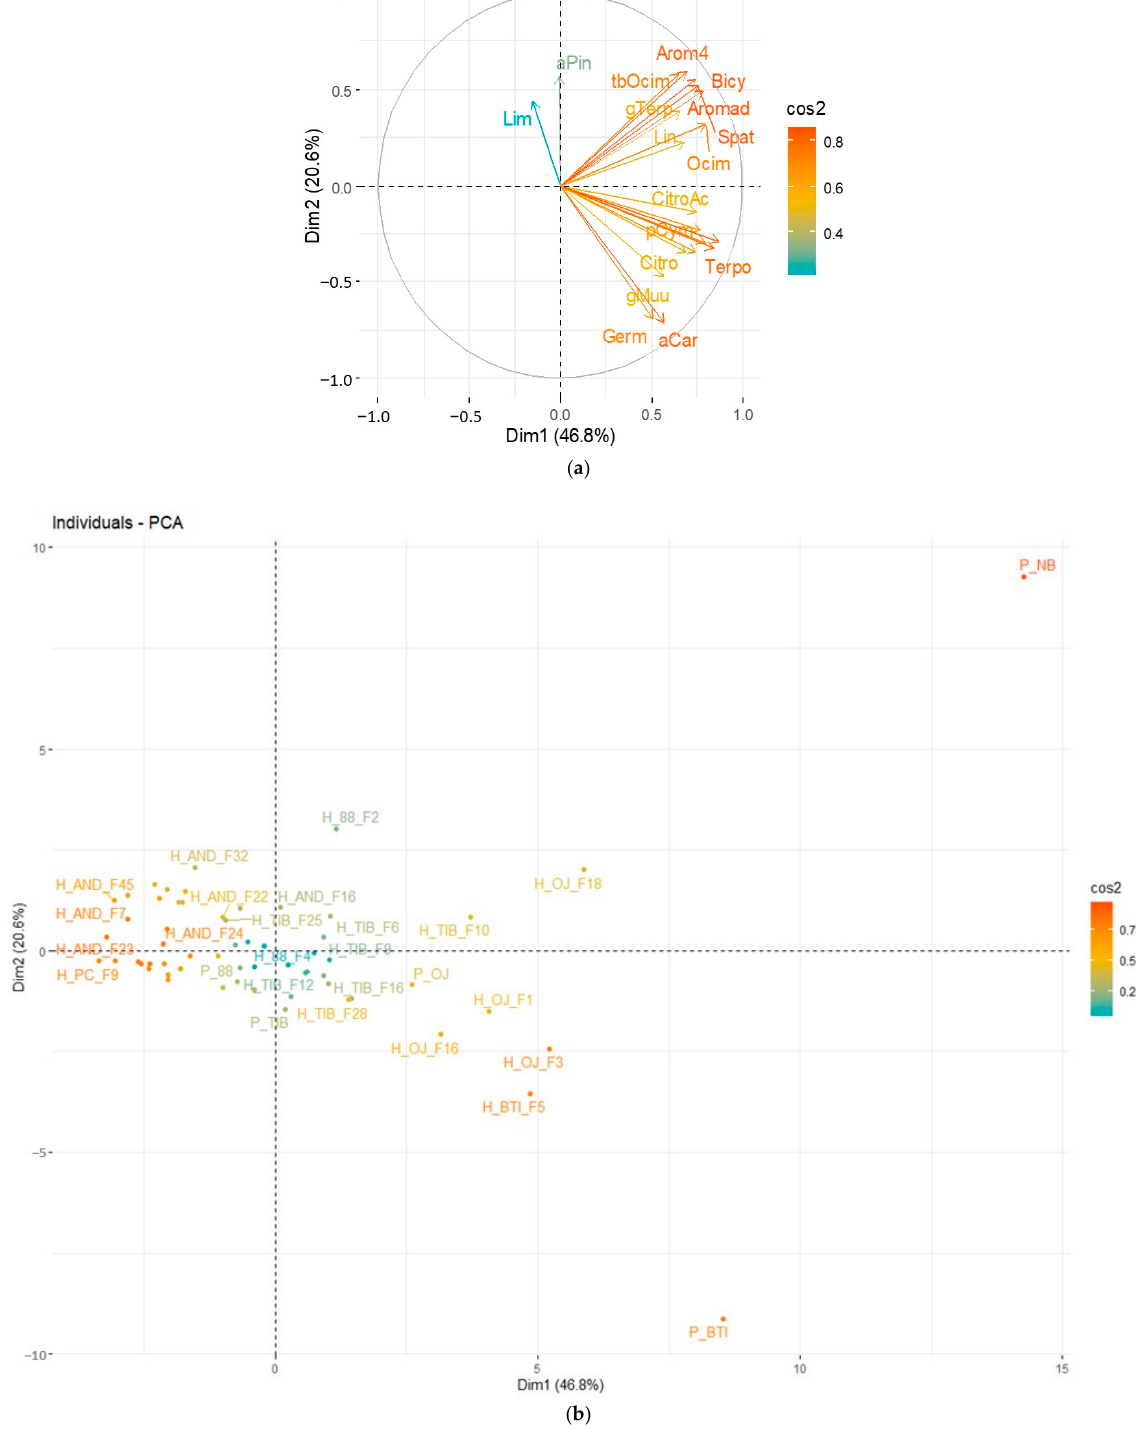
Figure 5. PCA plot released on the eight cultivars and hybrids for the 20 molecules retained in the fingerprint of Noir de Bourgogne (mean values). Data from berries collected in 2020; mean values, normalized using the weight of berries. Individual labels with an ‘H’ correspond to the Hybrid plants (H_Cultivar_N ◦ of the hybrid plant), and with a ‘P’, the cultivars used in crossing to obtain these hybrid plants (P_Cultivar). ( a ) Representation of the variables in plan Dim1-Dim2 ( b ) Representation of the individuals (Figure 5b) on the factor